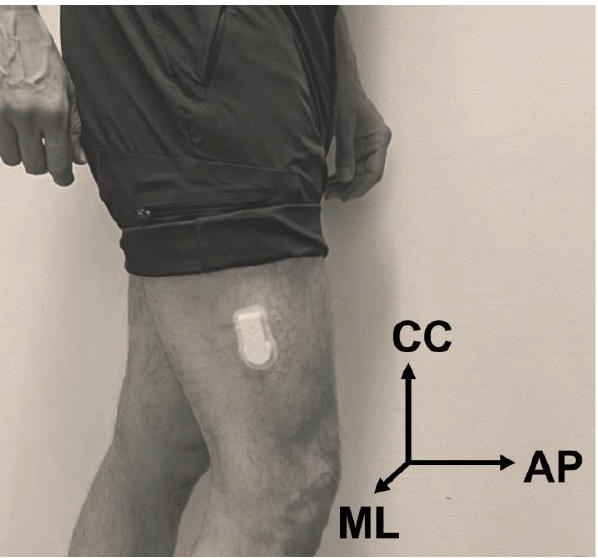
Figure 1. The photograph demonstrates the employed inertial measurement unit (IMU) at its loca- tion on the lateral distal side of the thigh and the corresponding coordinate axes (CC: craniocaudal, AP: anteroposterior, ML: mediolateral).